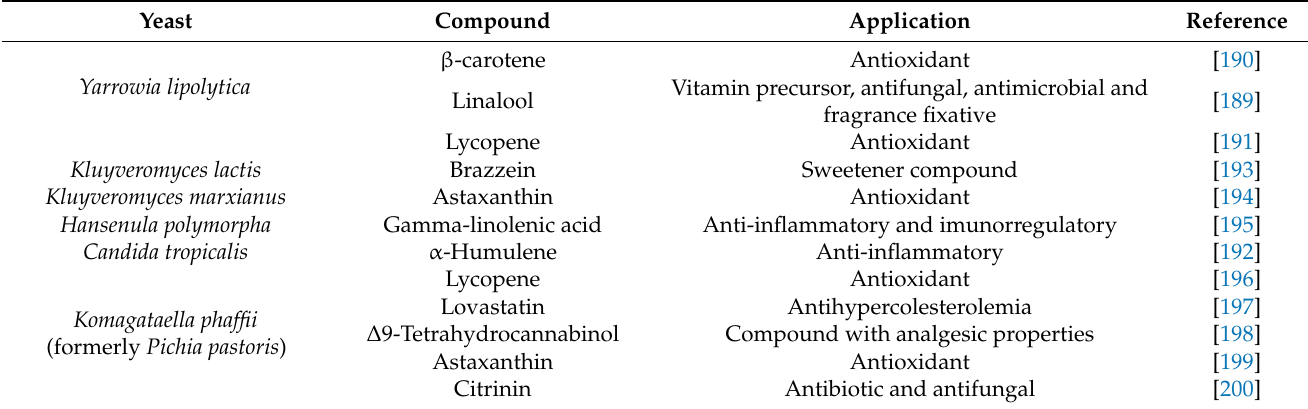
Table 3. Examples of biocompounds produced by engineered non- Saccharomyces